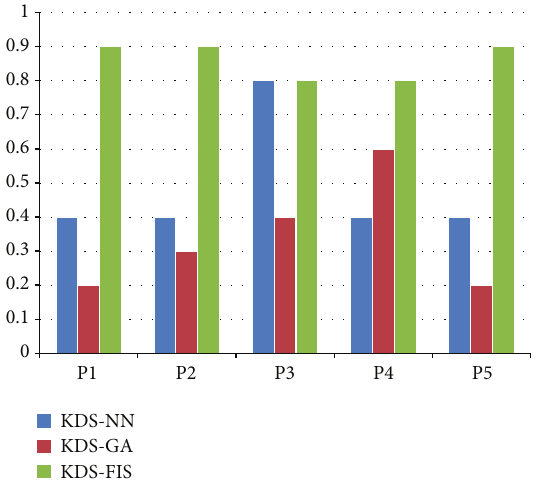
Figure 5: Relative performance evaluation based on approximate defuzzification